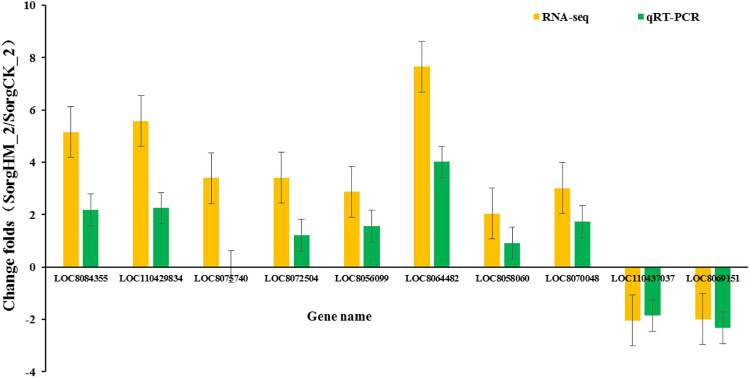
Comparison of the DEGs between qRT-PCR and RNA-seq.qRT-PCR was an effective method to verify gene expression changes originated from RNA-seq analysis. Although their relative expression values were not the same, the variation trends were consistent. Genes above the X-axis were up-regulated and the below genes were down-regulated.